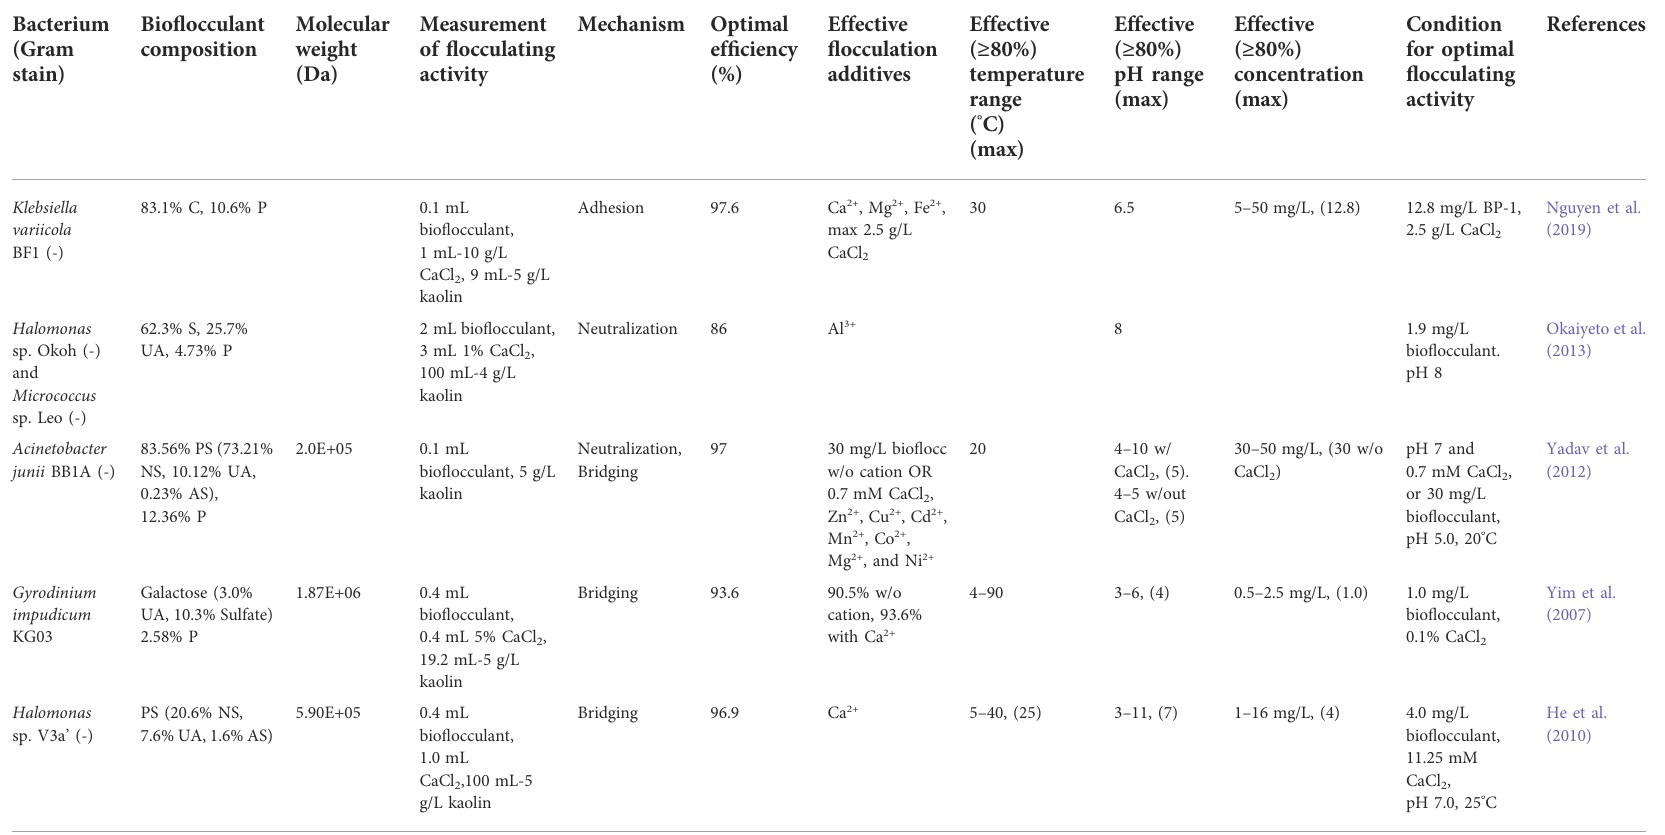
TABLE 7 Aquatic bacteria and algae and their fl occulation